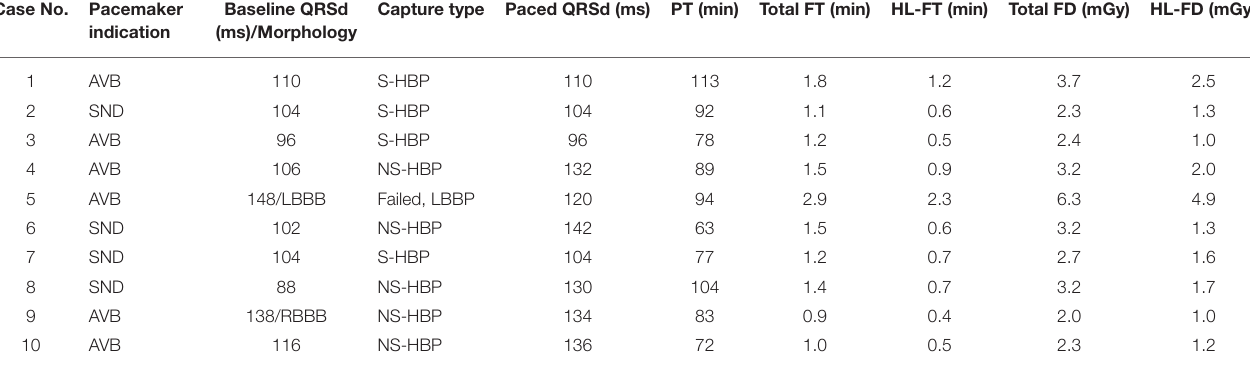
TABLE 2 | EAM-guided group case list. Case No. Pacemaker indication